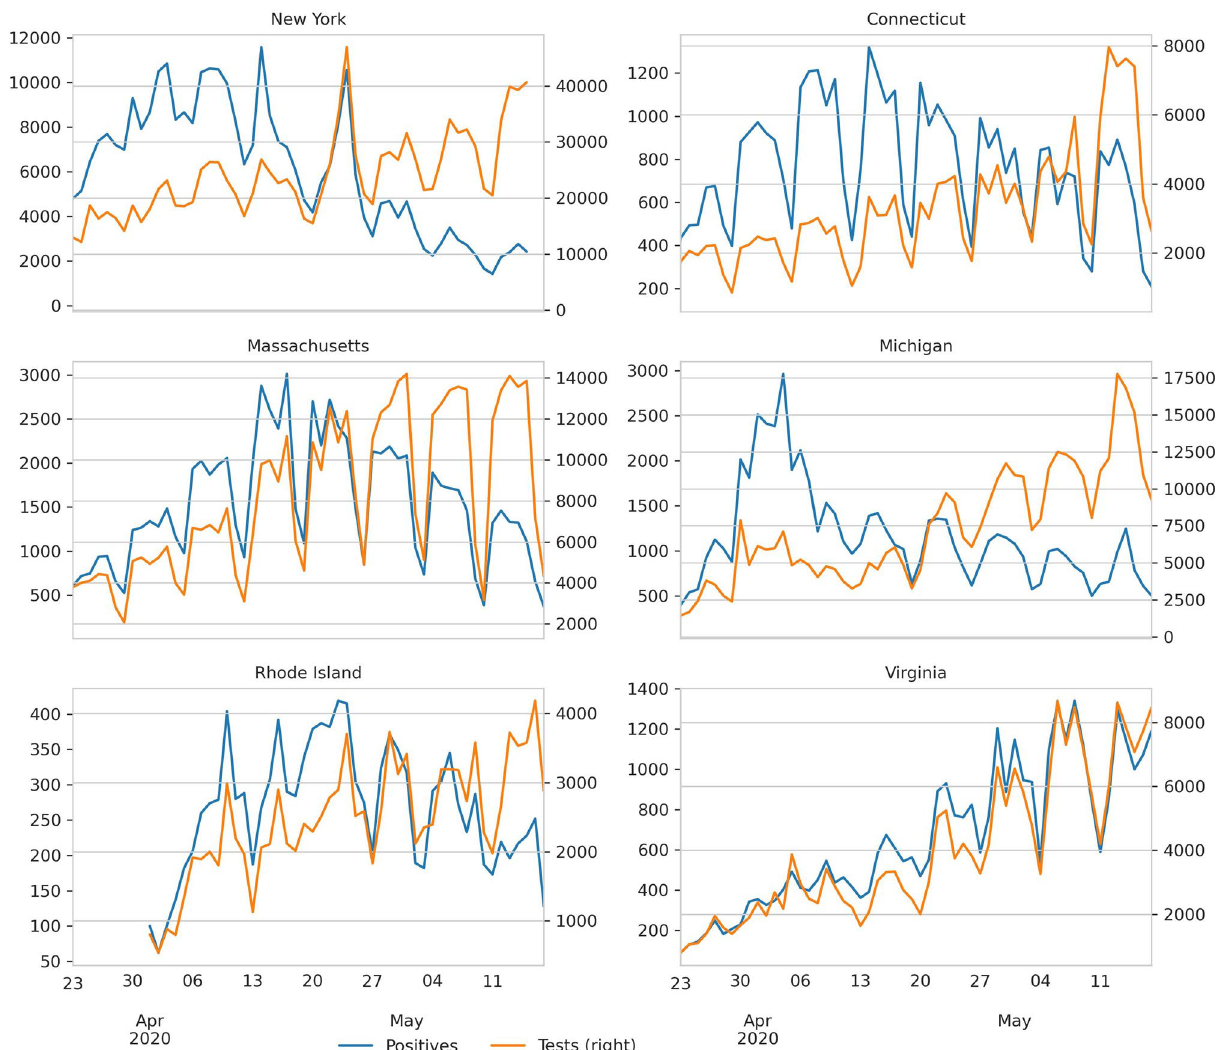
Figure 1. Daily number of new cases and test for each state in the